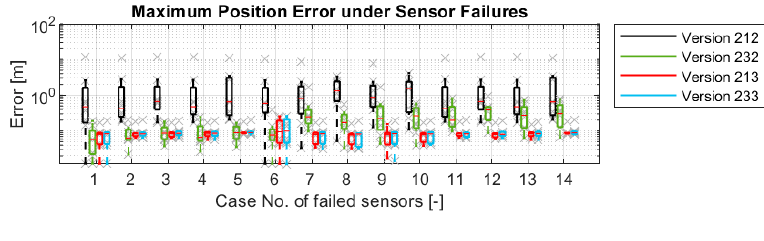
( d ) Figure 21. Simulation results of different odometry versions under sensor failures: ( a ) Maximum position errors; ( b ) Max- imum orientation errors; ( c ) Maximum position errors; ( d ) Maximum orientation errors.